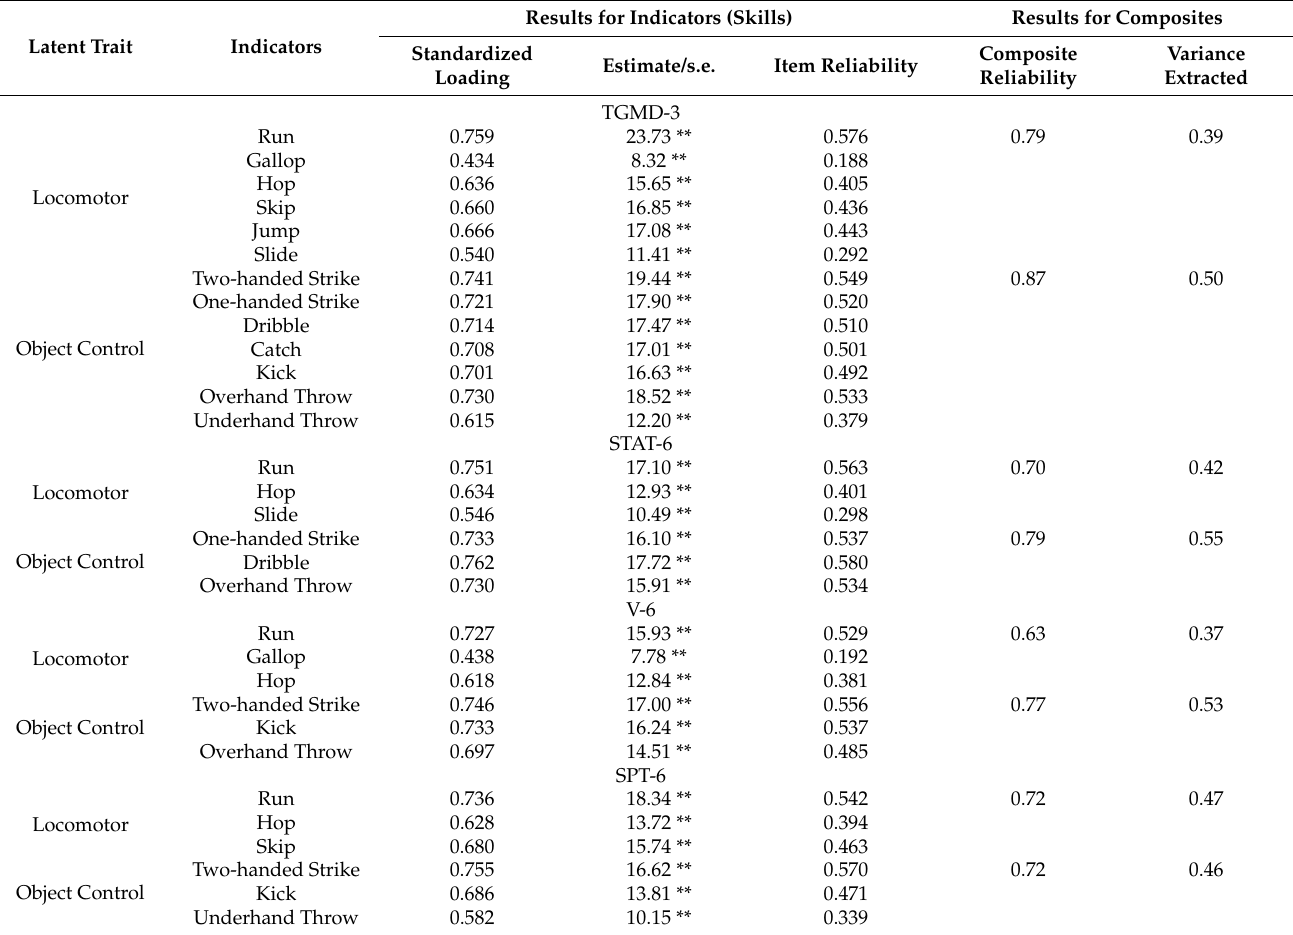
Table 4. Psychometric properties of the latent traits and motor skills that constitute each